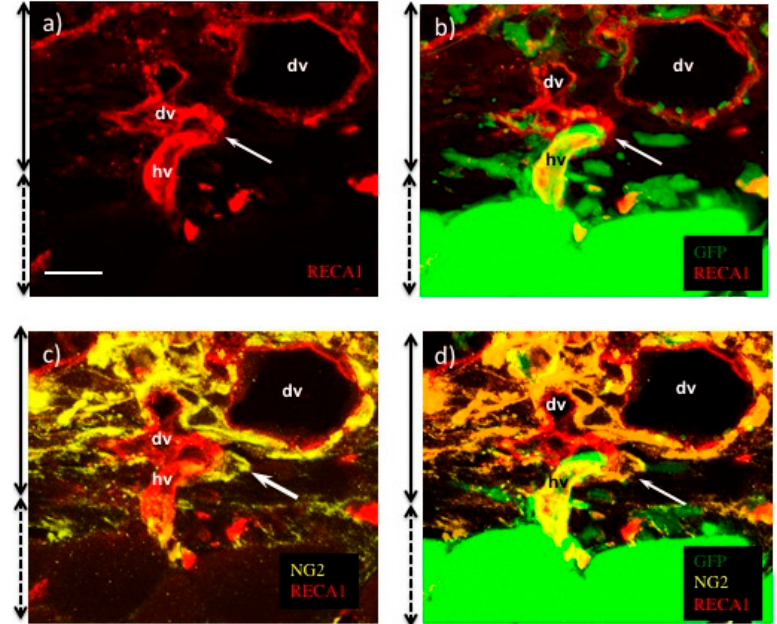
Figure 5. Immunofluorescence staining of the border areas of myocardial cell sheets transplanted in donor and GFP+ host rats. ( a ) An image of RECA-1+ ECs. ( b ) A merged image of Host GFP + cells and RECA-1 + ECs. ( c ) A merged image of RECA-1 + ECs and neural/glial antigen 2 (NG2) + pericytes. ( d ) A merged image of ( b ) and ( c ). dv = donor vasculature, hv = host vasculature, and arrow indicates the connecting point of dv and hv. Side solid lines with two directional arrows indicate the transplanted cell sheets area, and short dashed lines with two directional arrows indicate host tissues. Scale bar: ( a ), about 20 µ m. The scale bar was added with estimation from original